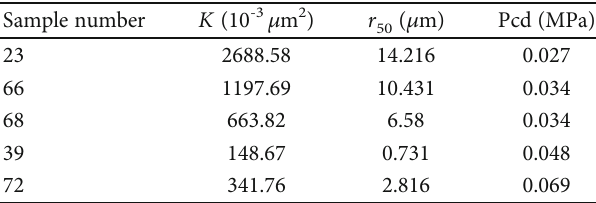
Table 6: HPMI test